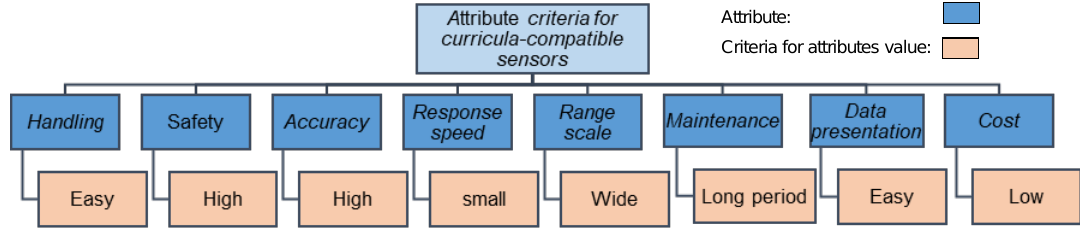
Figure 6 . Curricula-compatible attributes and criteria for corresponding attributes